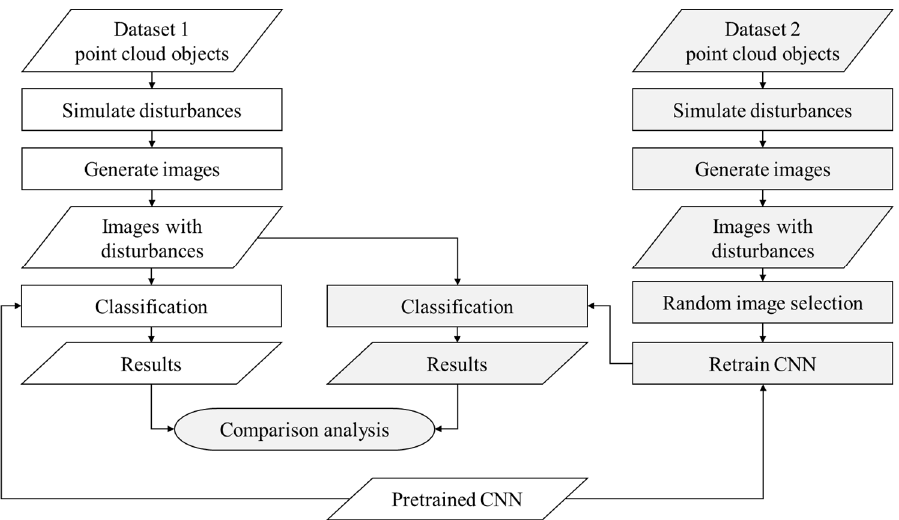
Figure 9. Workflow of the data comparison with the re-trained CNN.